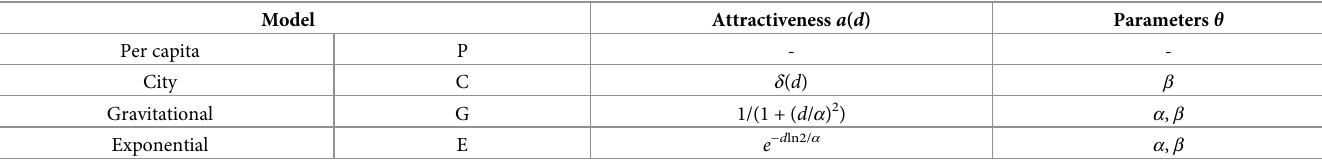
Table 1. The four models considered in this